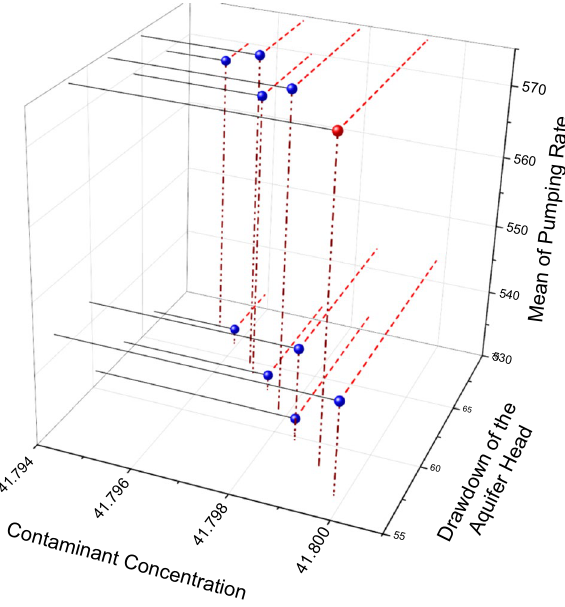
Fig. 9 Pareto front of NSGA-II algorithm in three objective